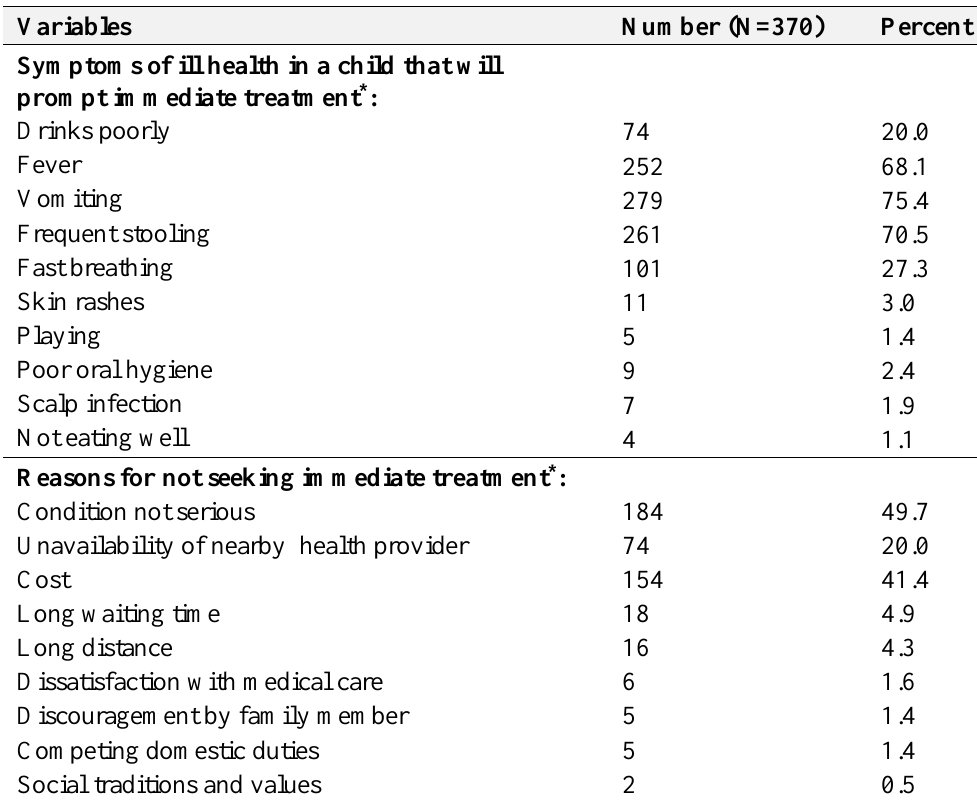
Table 3. Symptoms that prompt care seeking and reasons for not seeking immediate treatment